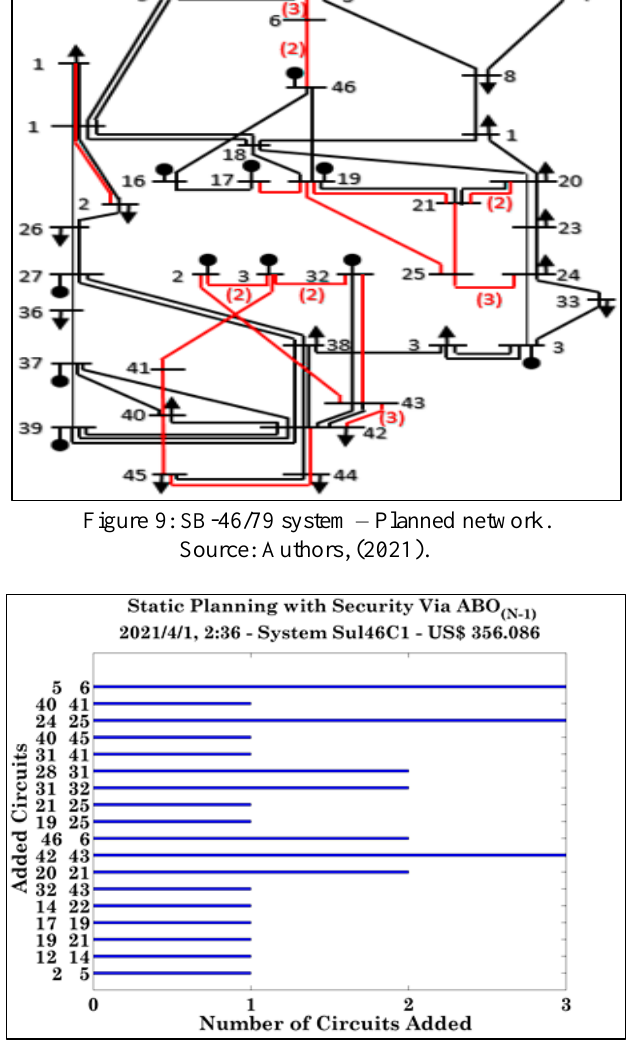
Figure 10: SB -46/79 system - Planned circuits. Source: ABO (N-1) optimizer, (2021).